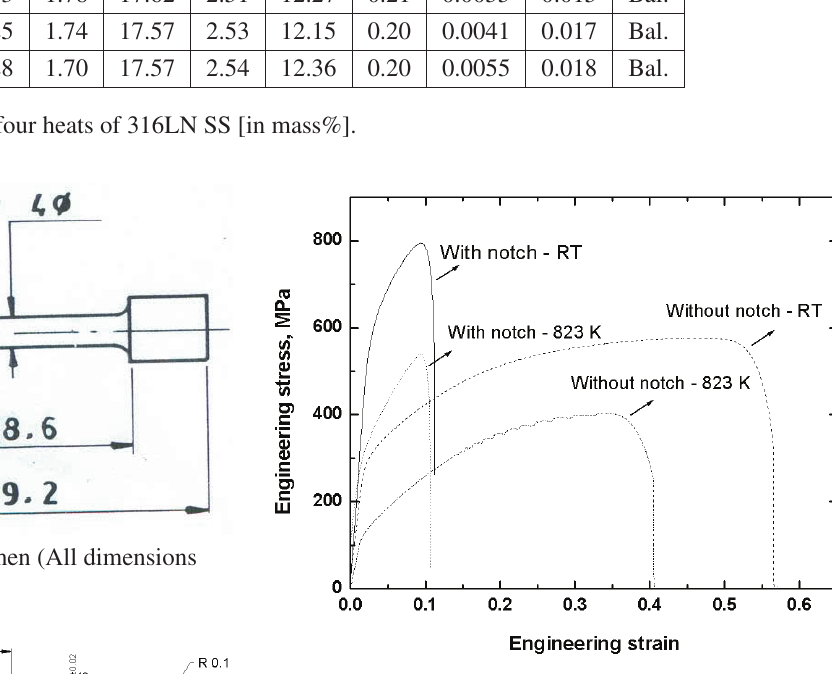
Figure 2. Influence of notch on stress – strain curve for 7N at room temperature (RT) and 823